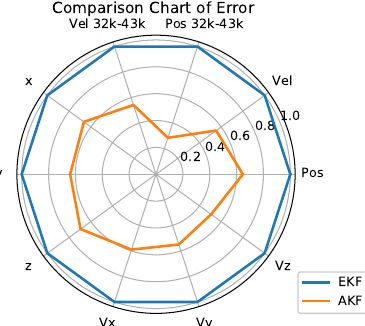
Figure 5. The radar figure shows the rate between estimation errors of EKF and AKF. The evaluation criterion is the mean error. The ’x’,’y’,’z’,’Vx’,’Vy’,’Vz’ represent the each state variable respectively. The ’Pos’,’Vel’ represent the position and velocity respectively. The ’Pos 32k-43k’,’Vel 32k-43k’ represent the position and velocity during 32,000 s–43,080 s